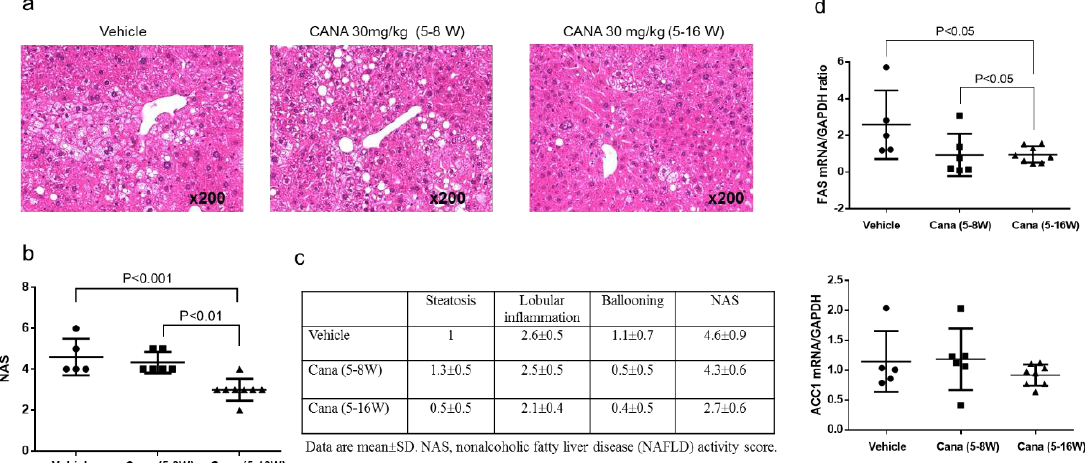
Figure 2. Canagliflozin continuous treatment attenuates steatohepatitis and de novo lipogenesis in the liver in STAM mice. ( a , b ) Representative microphotographs of liver sections stained with hematoxylin eosin and NAFLD activity score (NAS) in the three groups. Original magnification, × 200. Data are mean ± SD. ( c ) The scores of each component of NAS. ( d ) mRNA expression of genes involved in lipogenesis.